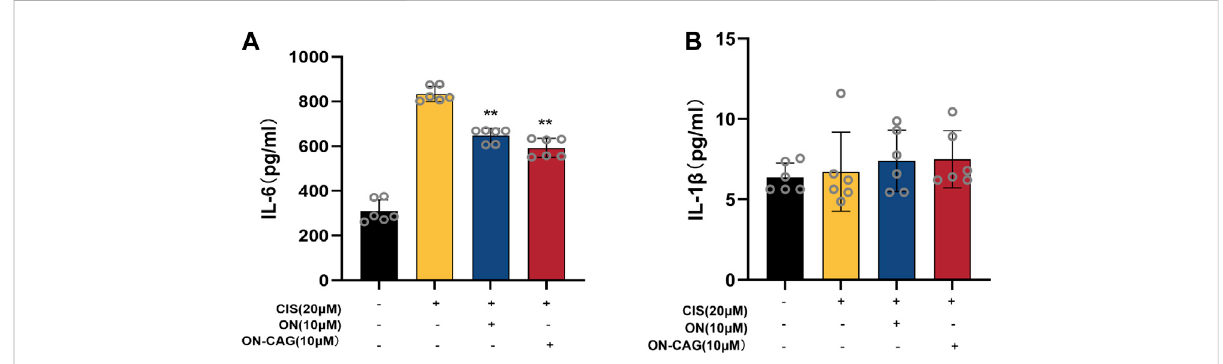
FIGURE 7 The effect of ON-CAG on cisplatin-induced IL-6 (A) and IL-1 β (B) expression in HK-2 cells. HK-2 cells were stimulated with 20 μ mol/L cisplatin for 24 h and then treated with 10 μ mol/L ON or ON-CAG for 24 h. Data were presented as the mean ± S.E.M. ( n = 6).* *p < 0.01 compared with the cisplatin